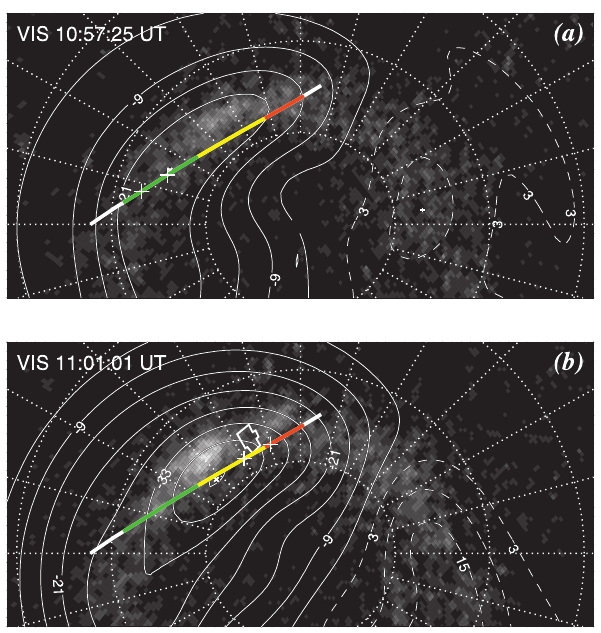
Fig. 6. The ionospheric footprint of the DMSP-F11 satellite tra- jectory between 10:55 UT and 11:05 UT on 24 November 1998 overlaid onto the VIS Earth Camera images of the ultraviolet aurora from (a) 10:57:25 UT and (b) 11:01:01 UT. The satellite footprint has been colour-coded to indicate the particle regimes traversed by the satellite, according to the electron and ion spectra in Fig. 2. The potential contours deduced from the map potential technique (Ruo- honiemi and Baker, 1998) for (a) the 10:57 UT and (b) the 11:01 UT radar scans have been superimposed over the VIS images. The white crosses on the DMSP track denote where the satellite foot- print was during the nearest HF radar scan that includes the auroral